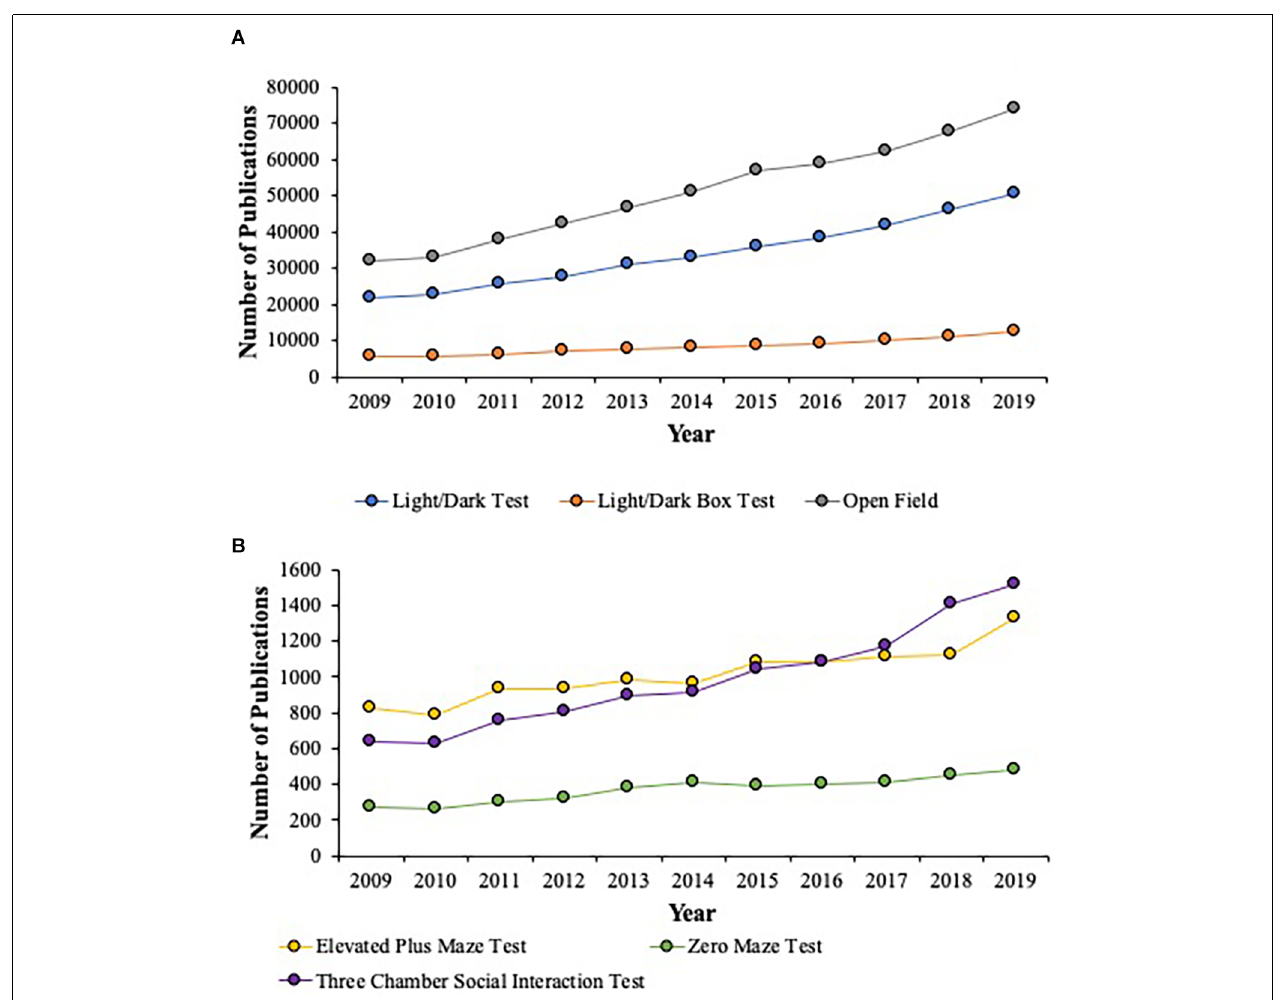
FIGURE 2 | This figure illustrates the number of publications for the Light/Dark Test, Light/Dark Box Test, and the Open Field Test (A) and the Elevated Plus Maze, Zero Maze Test, and the Three Chamber Social Interaction Test (B) from 2009 to 2019 that populated from Elsevier’s Science Direct search engine. The data show that from 2009 to 2019, across all the behavioral tests noted above, there is a range of 43%–62% increase in their use across the last decade. The most popular behavioral tests used are the Open Field (Gray; A ), the Light/Dark Test (Blue; A ), followed by the Three Chamber Social Interaction Test (Purple; B ), and the Elevated Plus Maze (Yellow; B ). The Light/Dark Box Test (Orange; A ) and the Zero Maze Test (Green; B ) are used less than the Light/Dark Test (Blue; A ) and the Elevated Plus Maze (Yellow; B ). Across all behavioral tests, the Zero Maze Test was utilized the least (Green; B ).